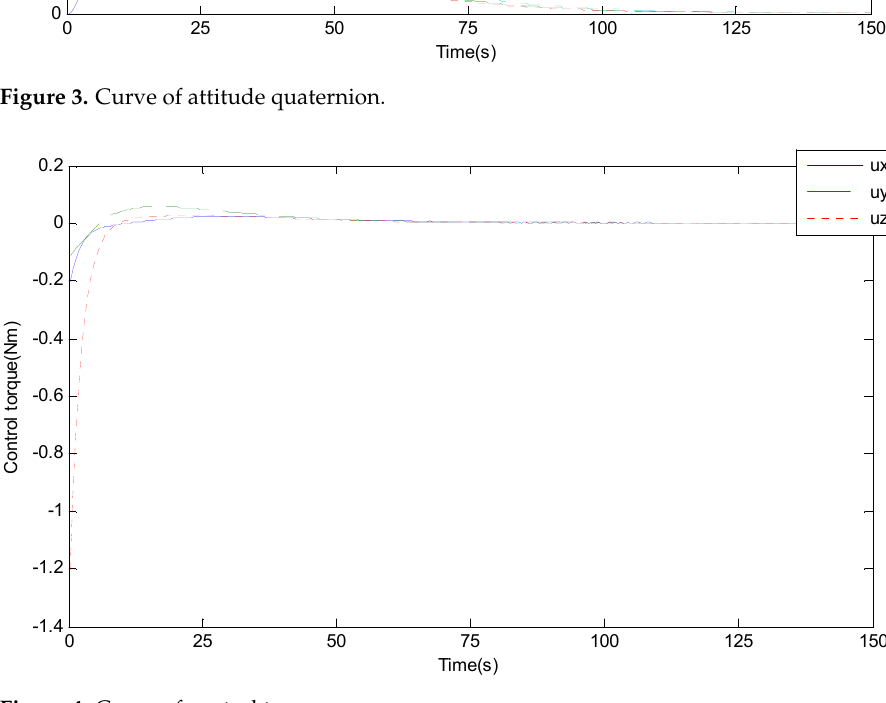
Figure 4. Curve of control torque.